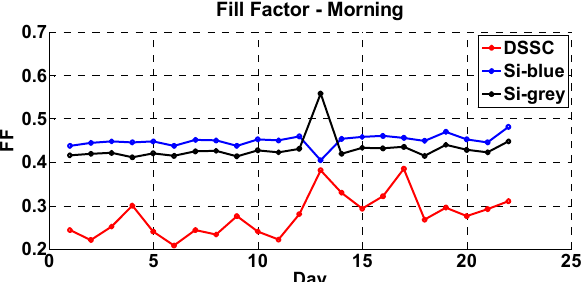
Photonics 2019 , 6 , x FOR PEER REVIEW Figure 23. Morning Fill Factor (FF) trends of the three generation systems. Figure 23. Morning Fill Factor (FF) trends of the three generation systems. Figure 23. Morning Fill Factor (FF) trends of the three generation systems.